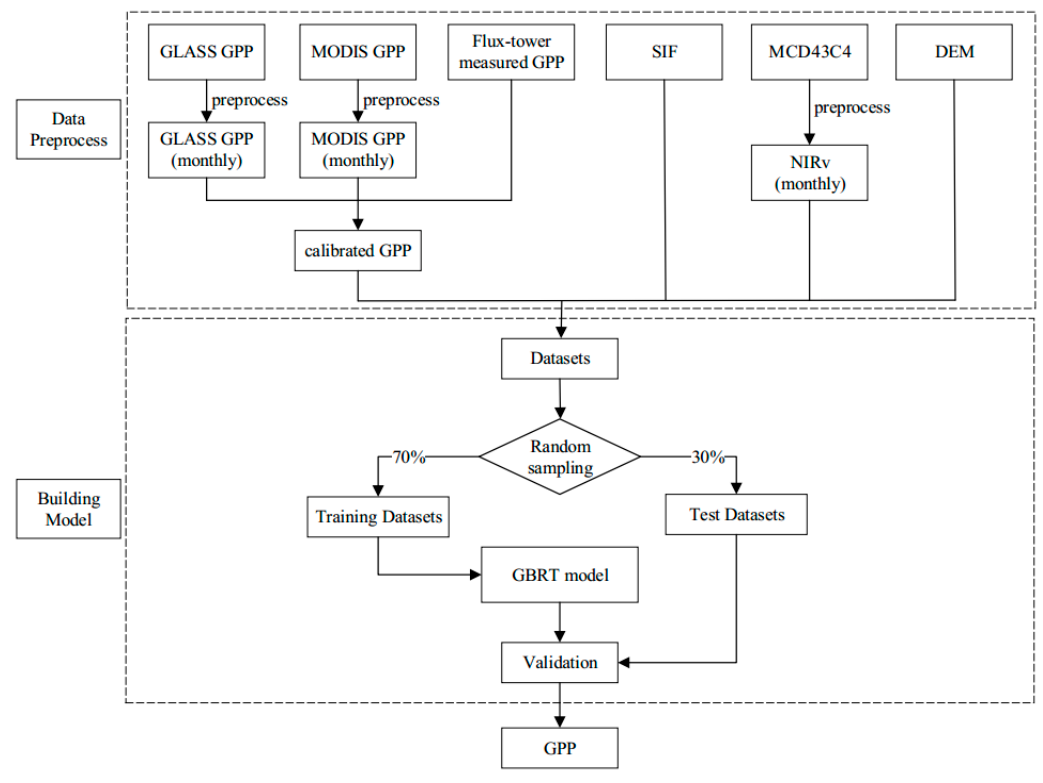
Figure 1. Flowchart of the global GPP estimation from GOSIF SIF data.